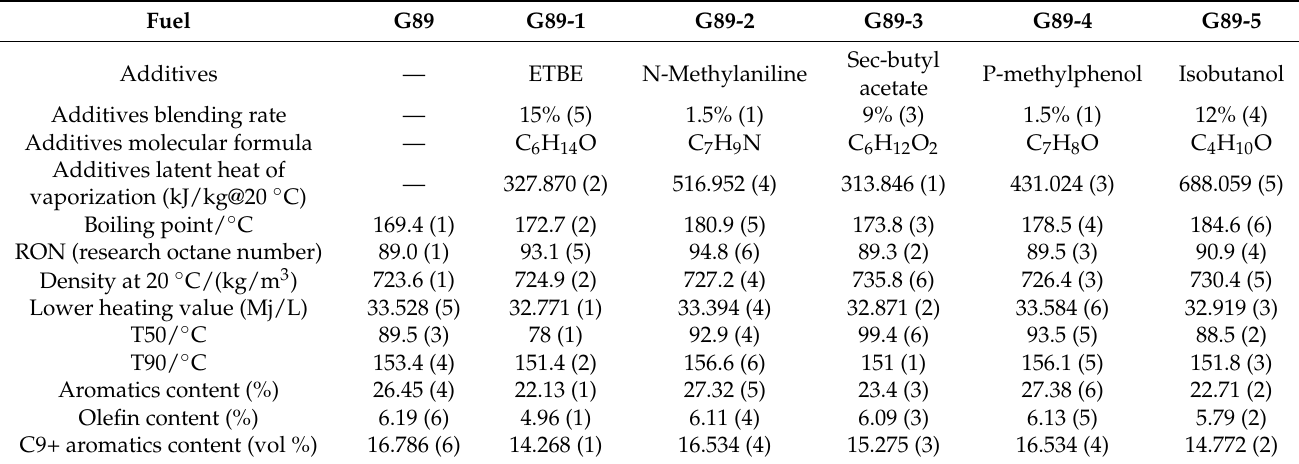
Table 4. The physical and chemical properties of the test